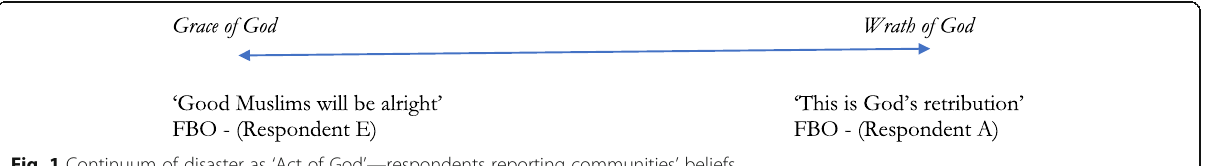
Fig. 1 Continuum of disaster as ‘ Act of God ’— respondents reporting communities ’